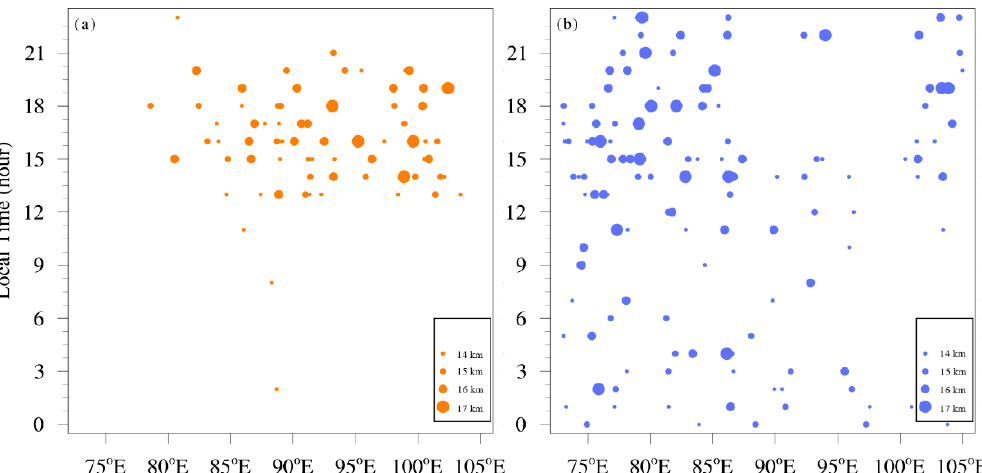
Figure 9. Spatiotemporal distribution of DCSs over ( a ) the TP, and ( b ) the SS. Each dot represents a DCS. The size of dots varies with Maxht20 of the DCSs.